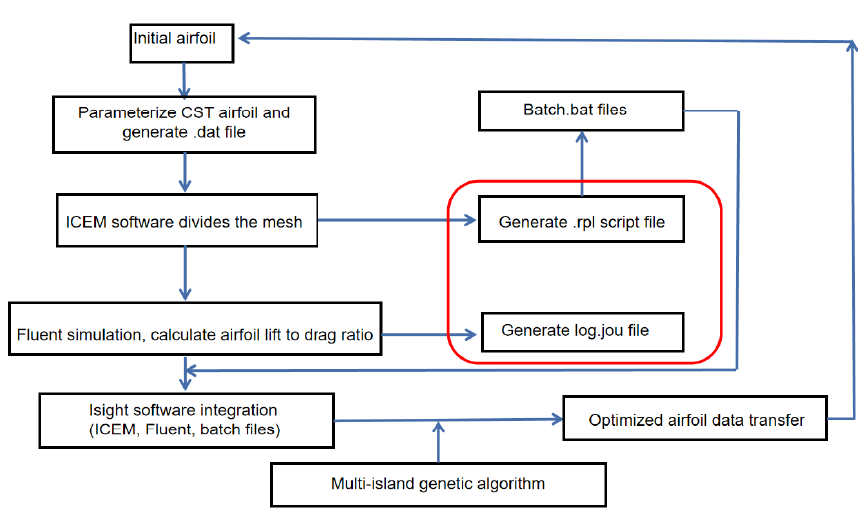
Figure 8. Calculation process.